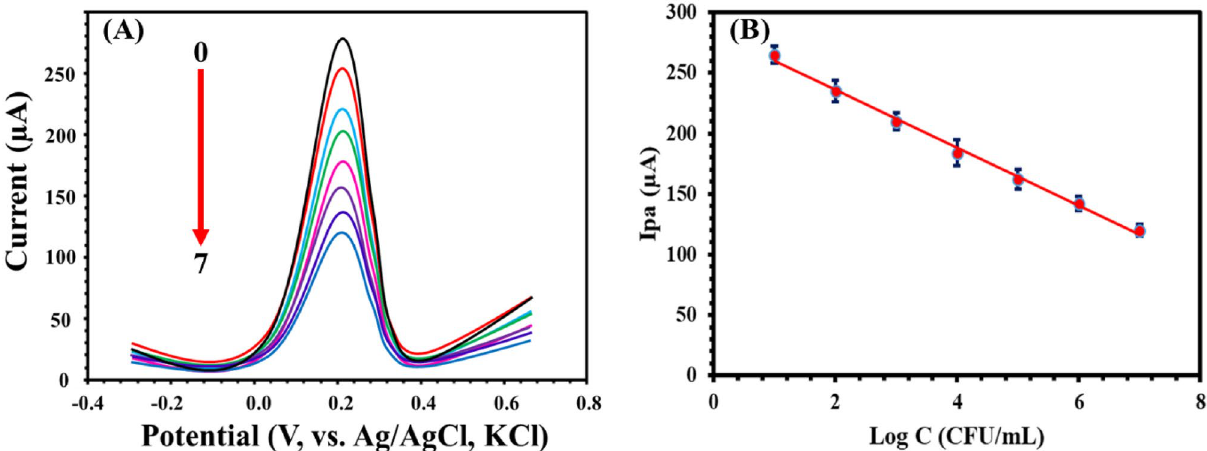
Figure 3. ( A ) DPVs of MIP-apt-AuNPs@ Fe 3 O 4 /GCE after incubation with different concentrations of the S. aureus (0:0, 1:10 1 , 2:10 2 , 3:10 3 , 4: 10 4 , 5:10 5 , 6: 10 6 and 7: 10 7 CFU·mL −1 S. aureus in 0.1 M KCl containing 5.0 mM [Fe(CN) 6 ] 3−/4− and ( B ) is a calibration plot. Conditions of DPV are pulse height of 30 mV, pulse width